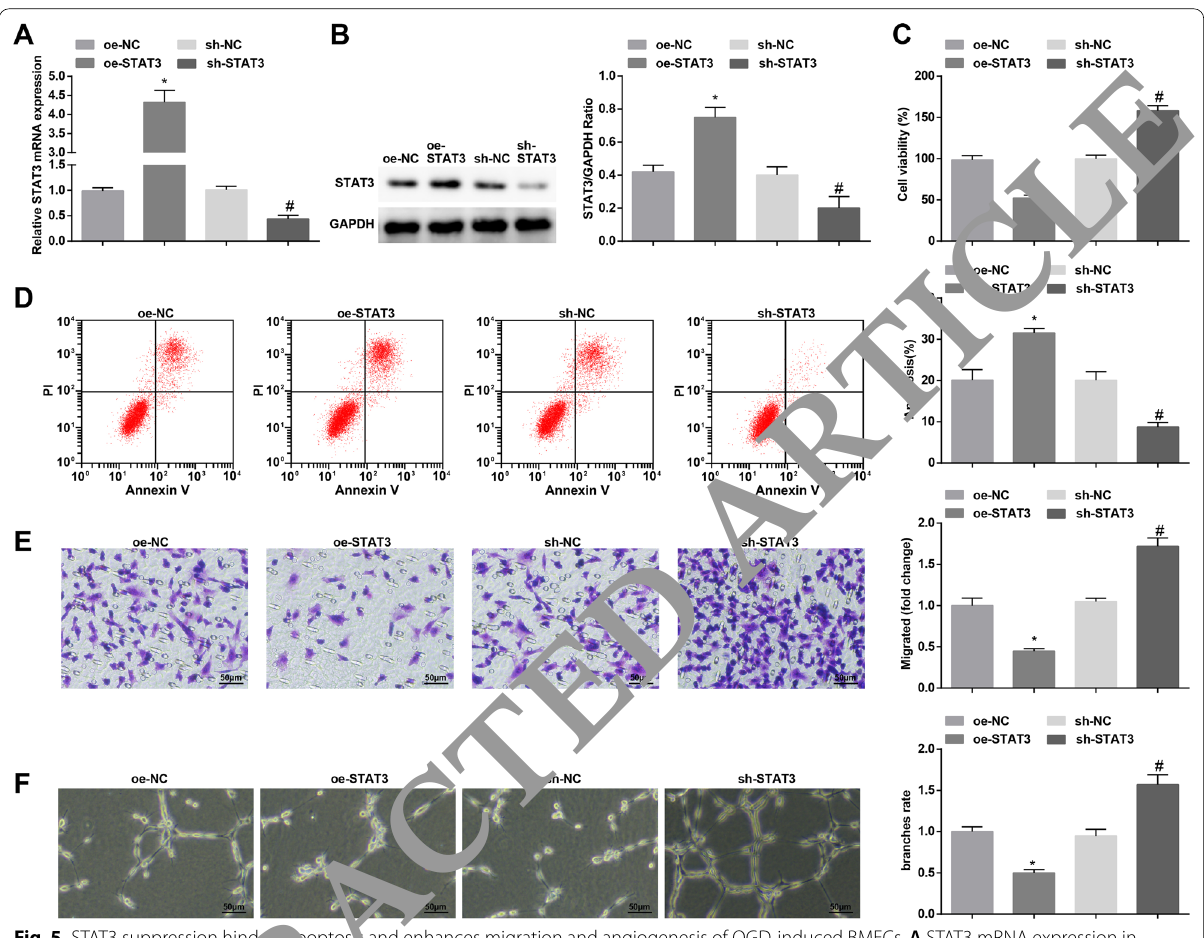
Fig. 5 STAT3 suppression hinders apoptosis and enhances migration and angiogenesis of OGD-induced BMECs. A STAT3 mRNA expression in sh-STAT3- or oe-STAT3-transfected and OGD-induced BMECs detected by RT-qPCR; B STAT3 protein expression in sh-STAT3- or oe-STAT3-transfected and OGD-induced BMECs detected by western blot assay; C Viability of sh-STAT3- or oe-STAT3-transfected and OGD-induced BMECs detected by MTT assay; D Cell apoptosis of sh-STAT3- or oe-STAT3-transfected and OGD-induced BMECs detected by flow cytometry; E Cell migration of sh-STAT3- or oe-STAT3-transfected and OGD-induced BMECs detected by Transwell assay; F Angiogenesis of sh-STAT3- or oe-STAT3-transfected and OGD-induced BMECs detected by Matrigel method; N 3; * P < 0.05 compared with the oe-NC group; # P < 0.05 compared with the sh-NC group. The = data were expressed as mean standard ±